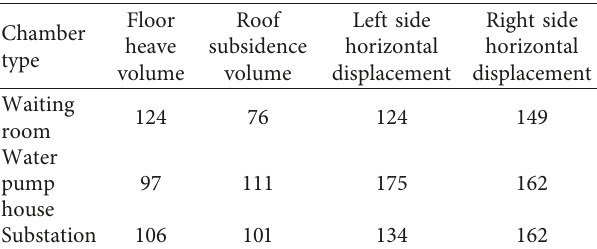
Figure 14: Support simulation model of the anchor and cable. Table 4: Deformation of surrounding rock of the chamber after adopting the new support scheme (unit: mm).